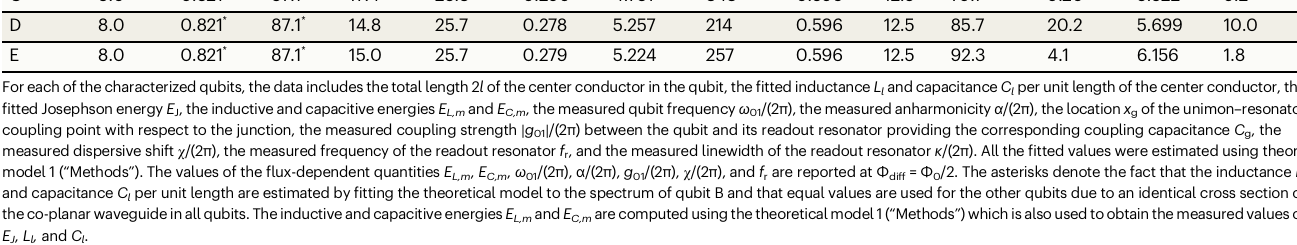
Table 2 | Results of coherence characterization and randomized-benchmarking (RB) experiments for the fi ve unimon